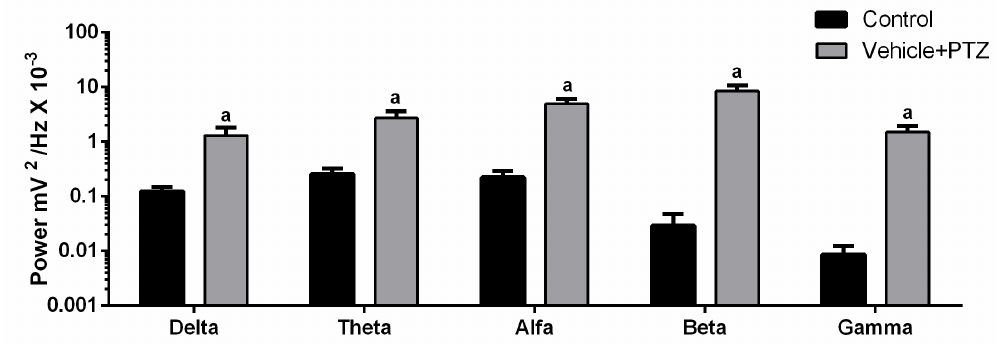
Figure 5. Comparison between brain oscillations power (Delta: 0.5–3 Hz, Theta: 3.5–7.5 Hz, Alpha: 8–12 Hz, Beta: 13–20 Hz and Gamma: 20–40 Hz) of the control group and vehicle + PTZ group (60 mg/kg). Graph expressed in logarithmic scale and (a) significant differences with control of each oscillation after Student’s T-test ( p < 0.05, n = 9).